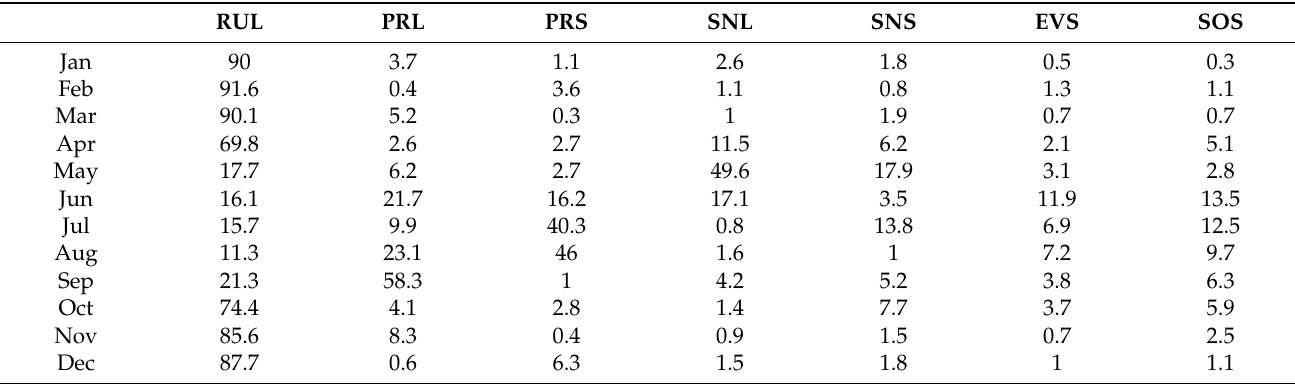
Table 2. Conditional dominance statistics SRI